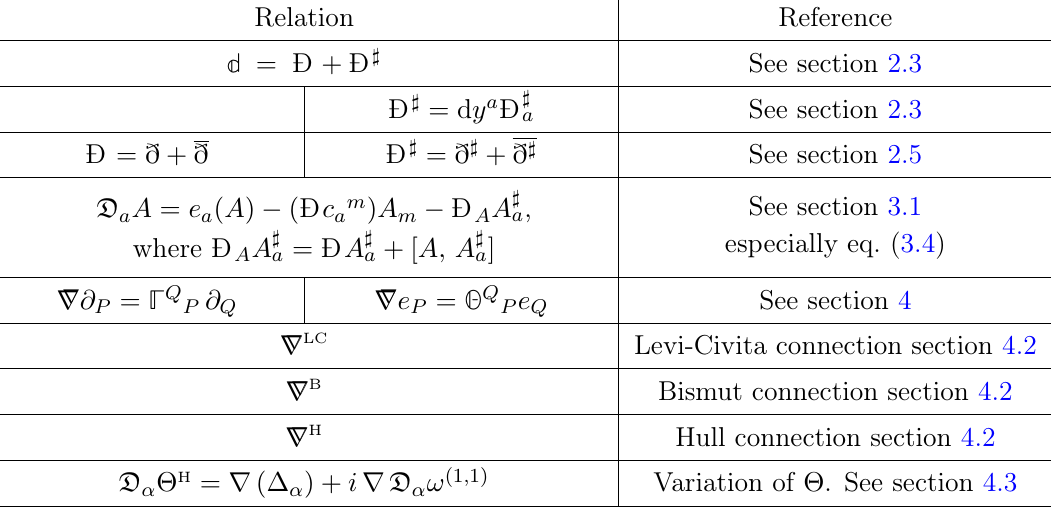
Table 2 . A table of derivatives used in the